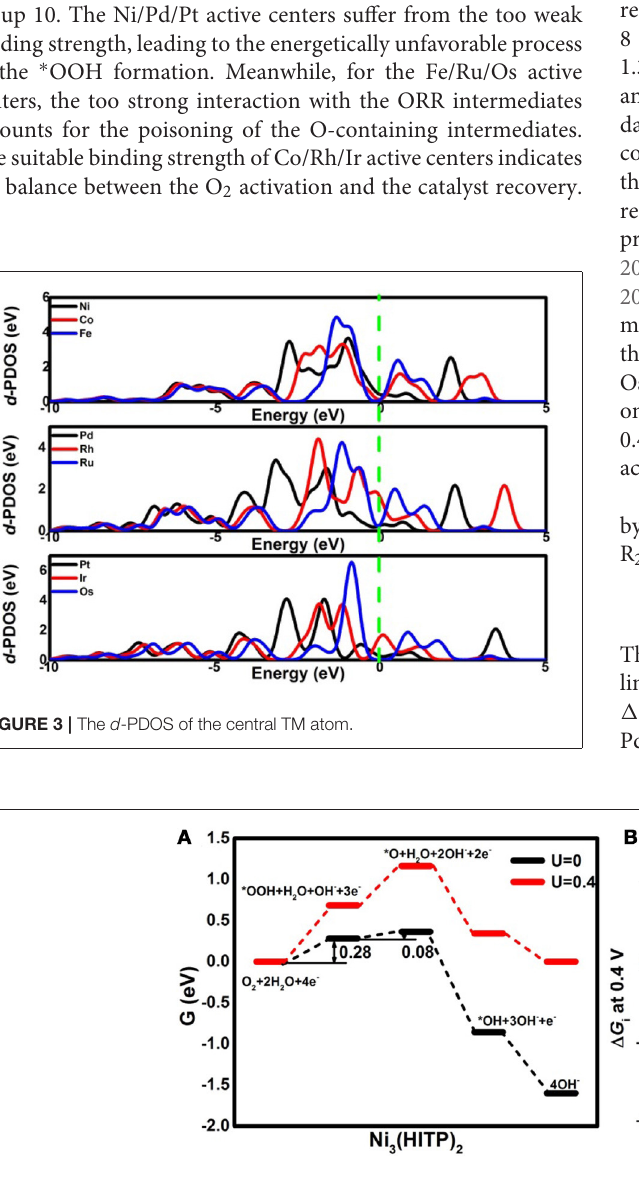
Frontiers in Chemistry |